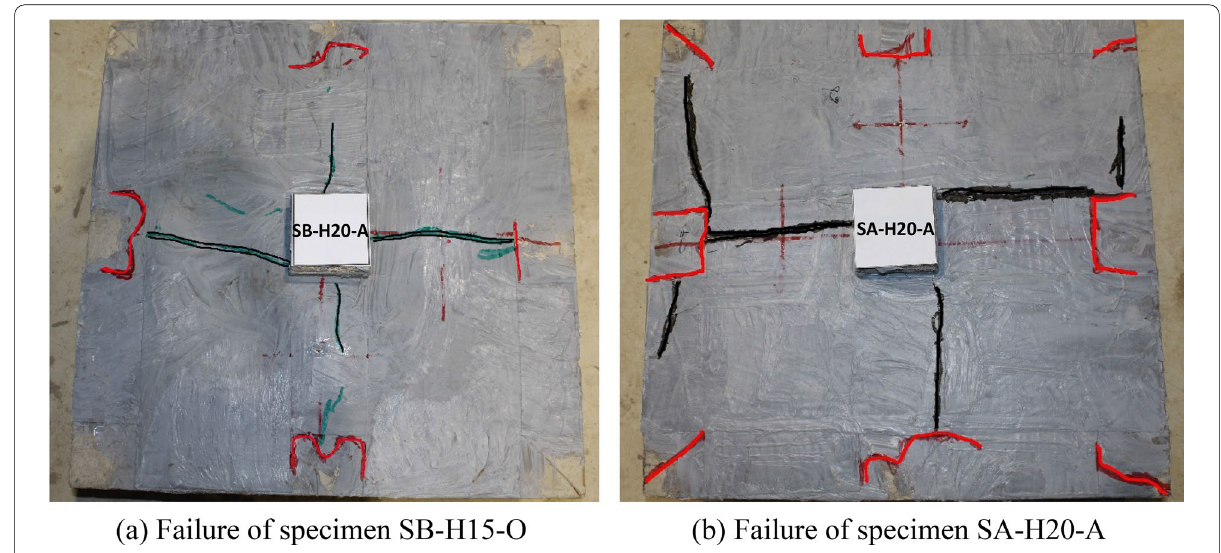
Fig. 6 Failure of specimens confined and strengthened by HFRP sheets.